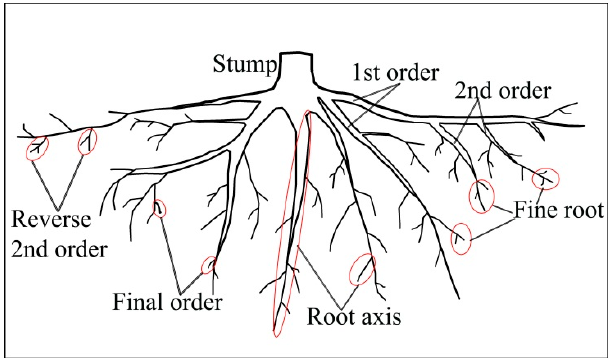
Figure 1. Diagram showing the root classification and the definition of a root axis. Segments with a diameter less than 2 mm on the tip of larger roots are also fine